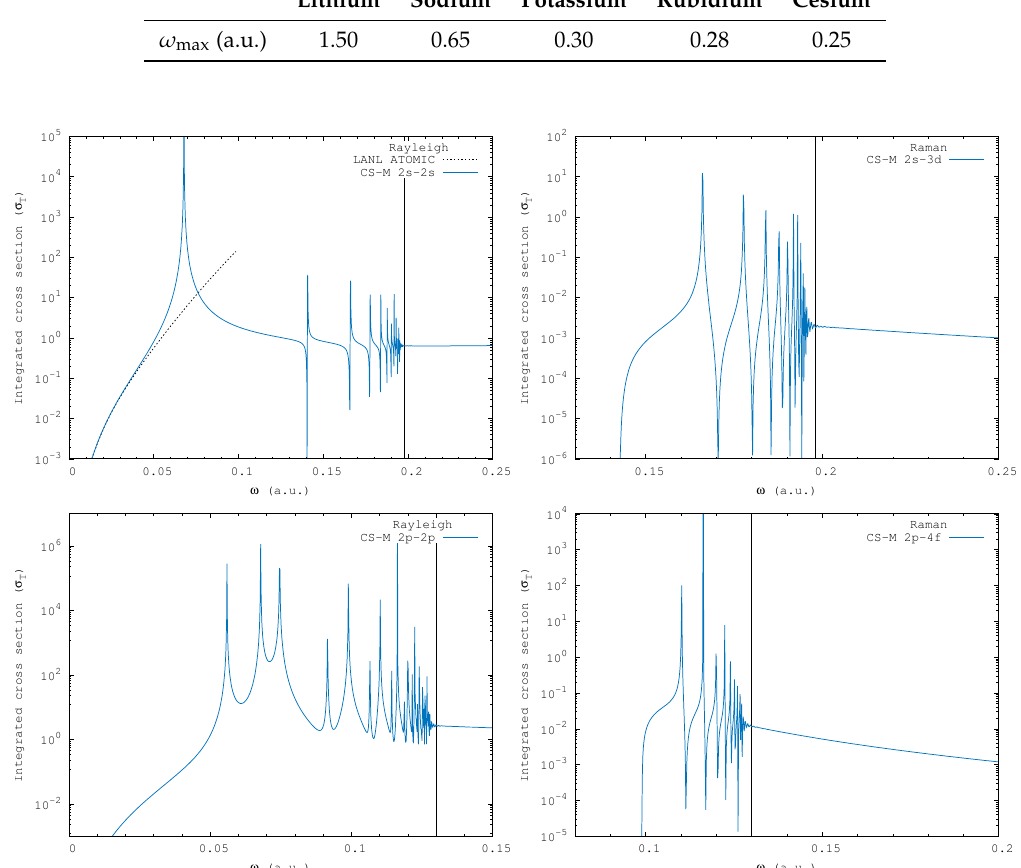
Figure 5. Cross sections for Rayleigh and Raman scattering on ground and excited states of lithium for fine structure combined levels. The ‘CS-M’ denotes cross sections calculated using the modified length form of the dipole operator in the CS method. The vertical line indicates the ionization threshold. The low energy approximation for the ground state Rayleigh cross sections used in the Los Alamos National Lab (LANL) ATOMIC code [5] is also